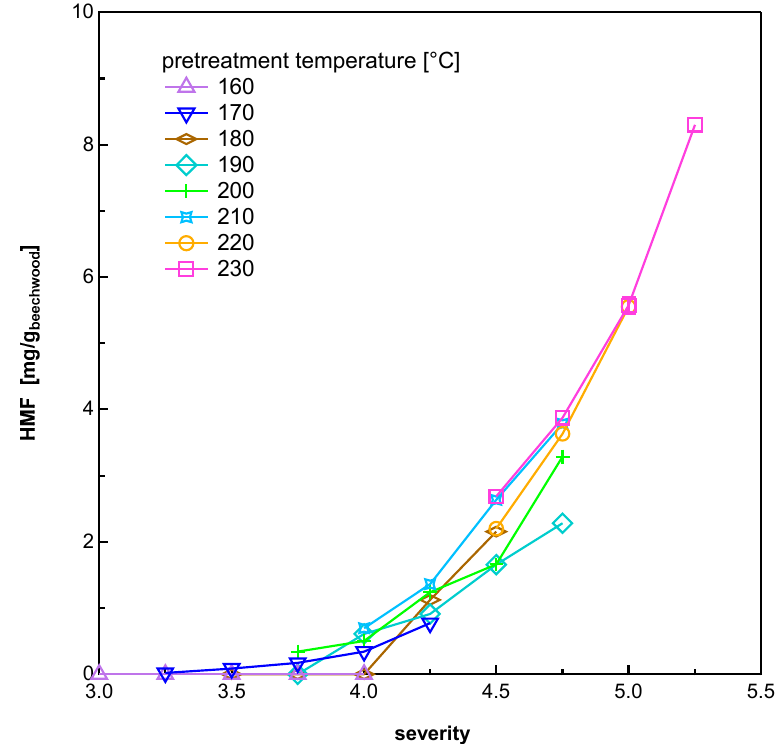
Figure 6. Formation of HMF during steam explosion pretreatment. The amount of HMF that is released into the prehydrolyzate during steam explosion pretreatment is shown as a function of the pretreatment severity and temperature.